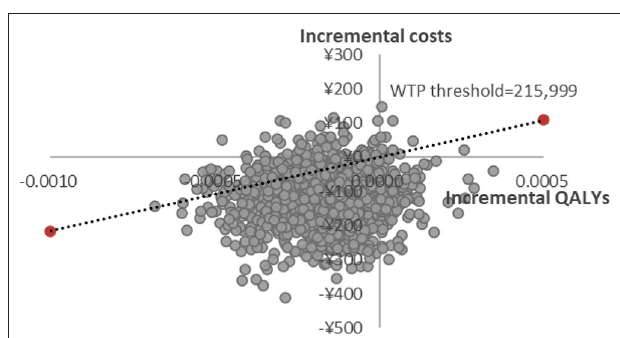
FIGURE 3 | Probabilistic sensitivity analysis of FosAPR vs. APR. WTP, willingness-to-pay; QALY, quality-adjusted life year.